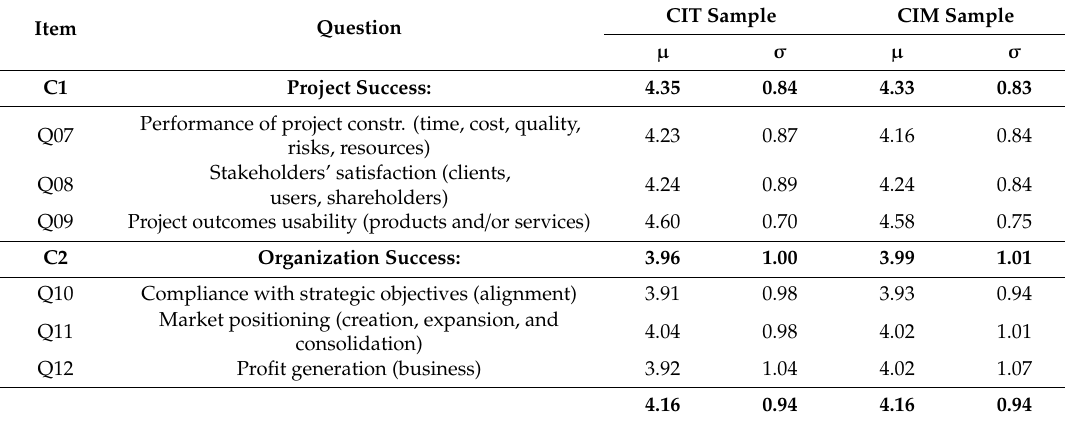
Table 11. Answers to questions related to project and organization success (1–5